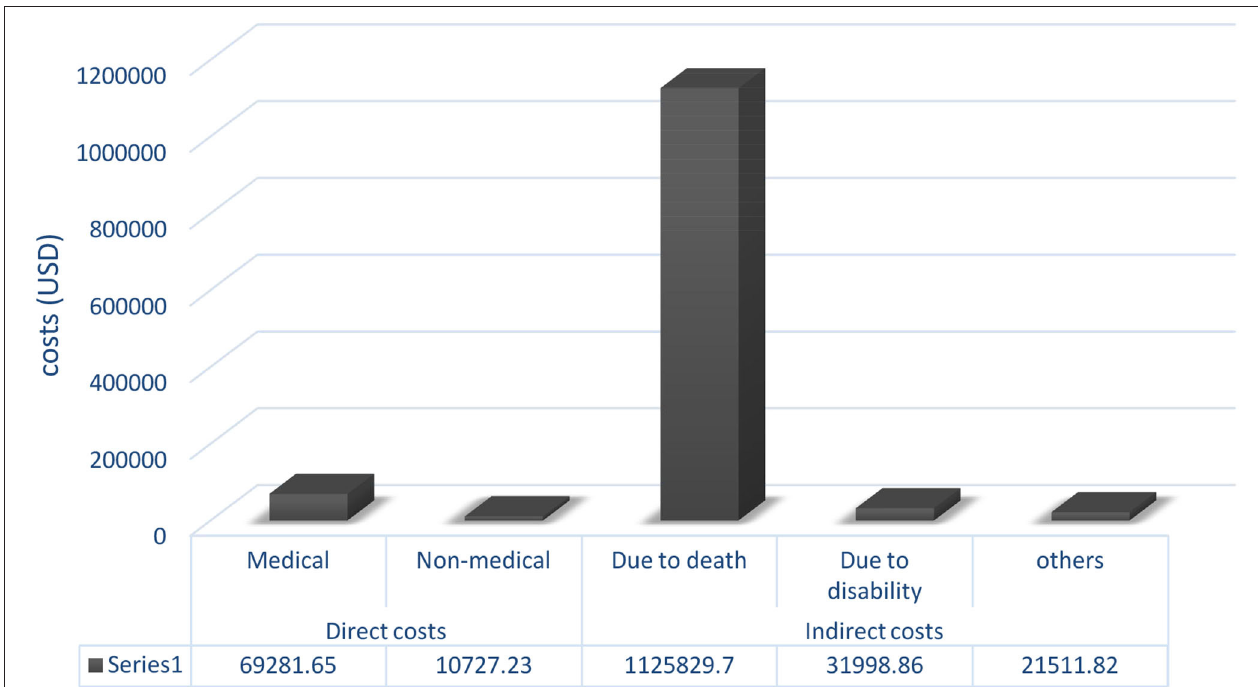
FIGURE 1 | Total costs of poisoning with mushrooms in Kermanshah province, Iran,